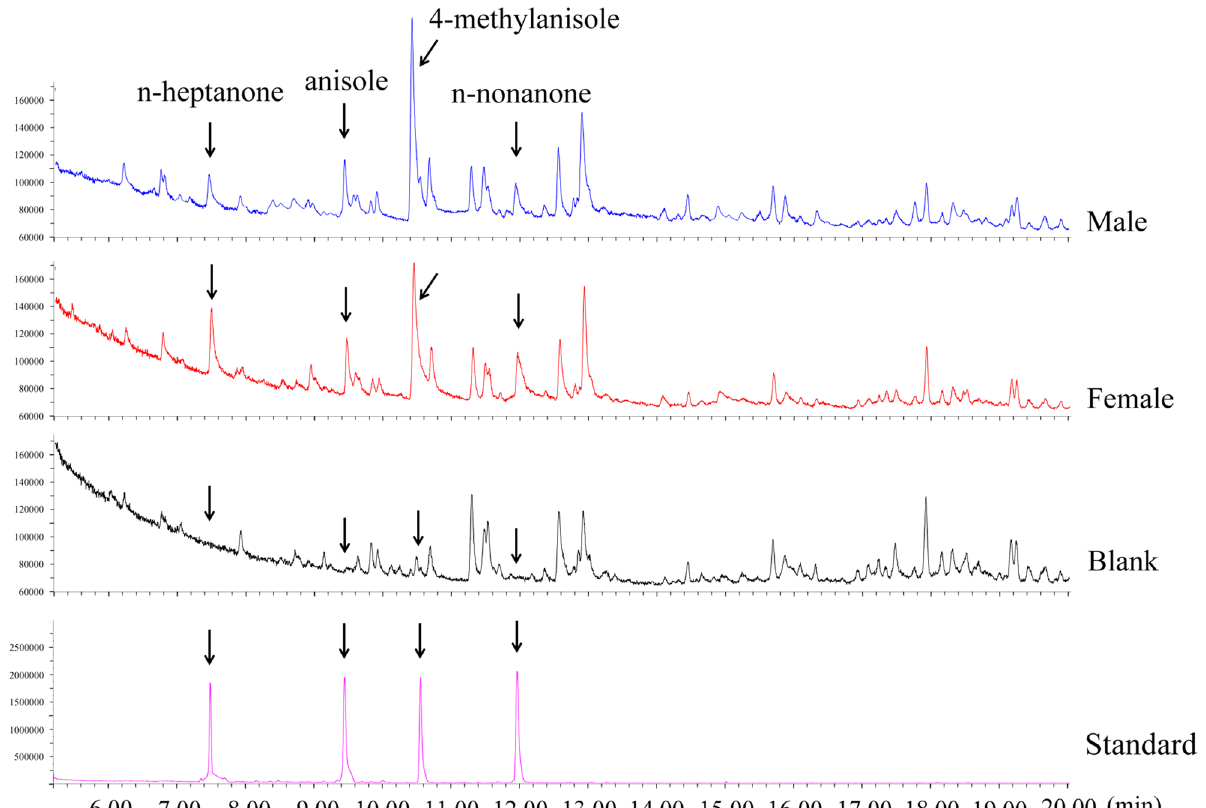
Figure 2. Total ion chromatograms of the volatiles collected from Protaetia brevitarsis males (blue), females (red), blank chamber (black), and authentic standards of n-heptanone, anisole, 4-methylanisole and n-nonanone (purple).